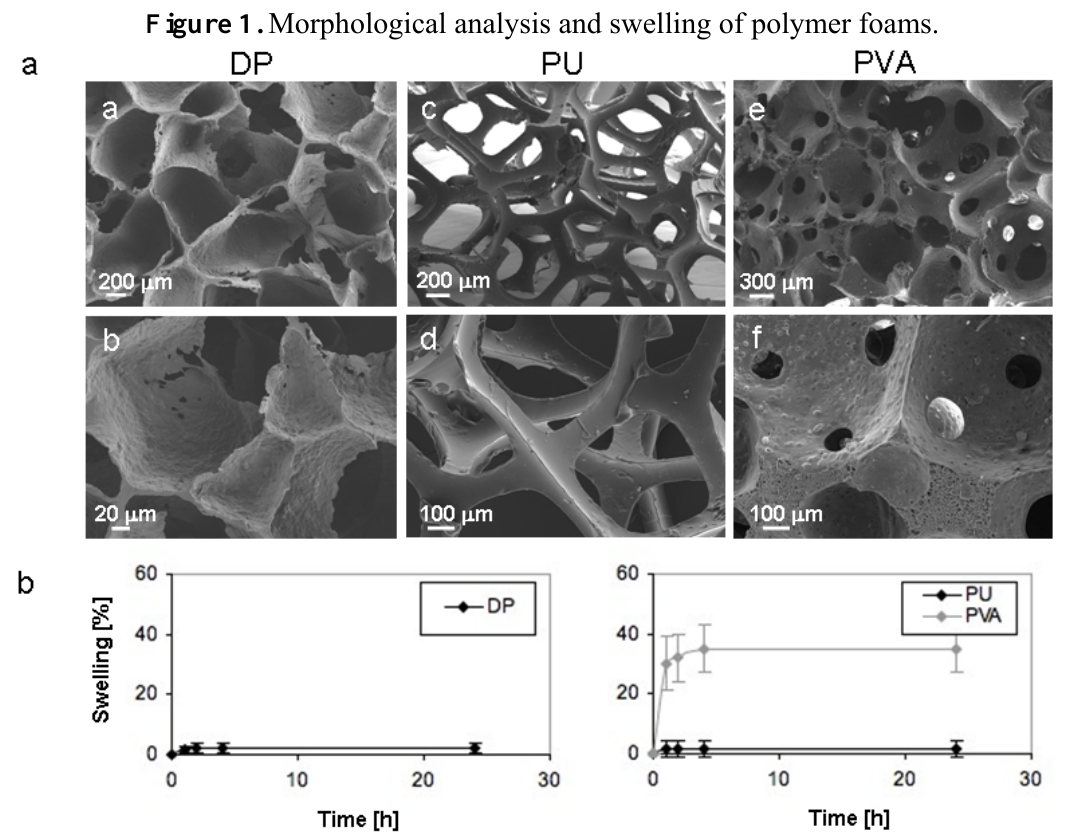
Figure 1. Morphological analysis and swelling of polymer foams.